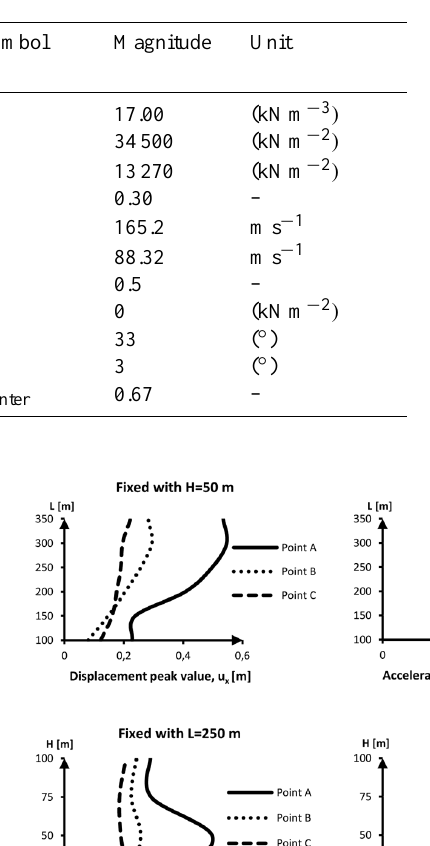
Table 1. Mechanical property of underlying soil (Yang, 1997) for validation of SSI model.